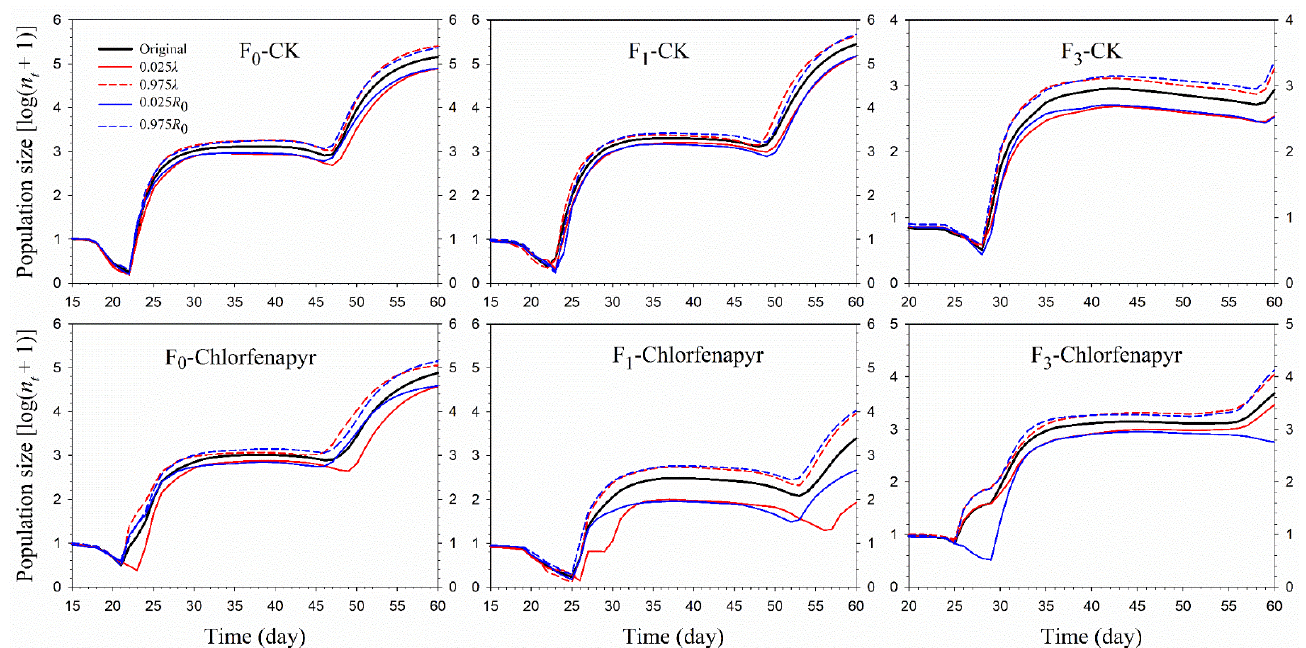
Figure 5. Population sizes of P . marginatus (F 0 , F 1 , and F 3 ) exposed to LC 30 dose of chlorfenapyr. CK represents the control.